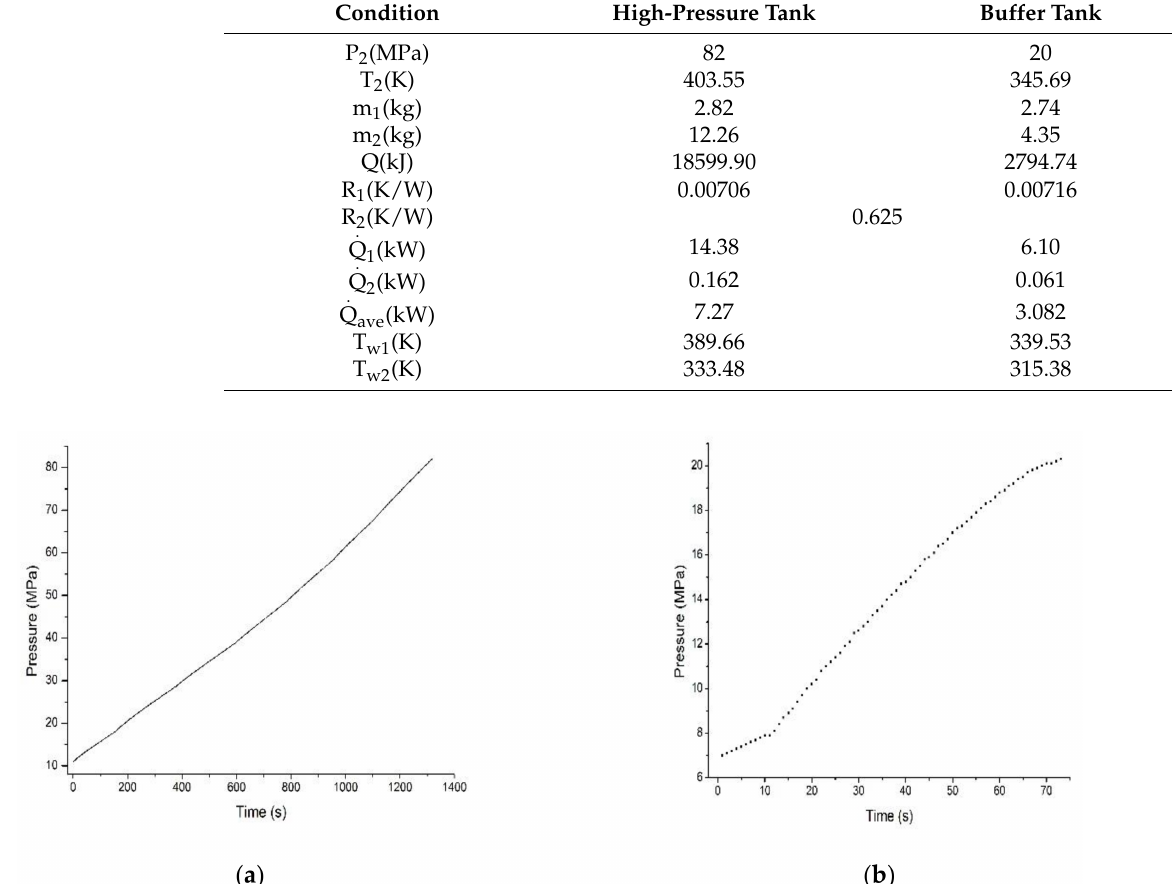
Table 7. Results of the second cycle of the compressed hydrogen storage tanks.